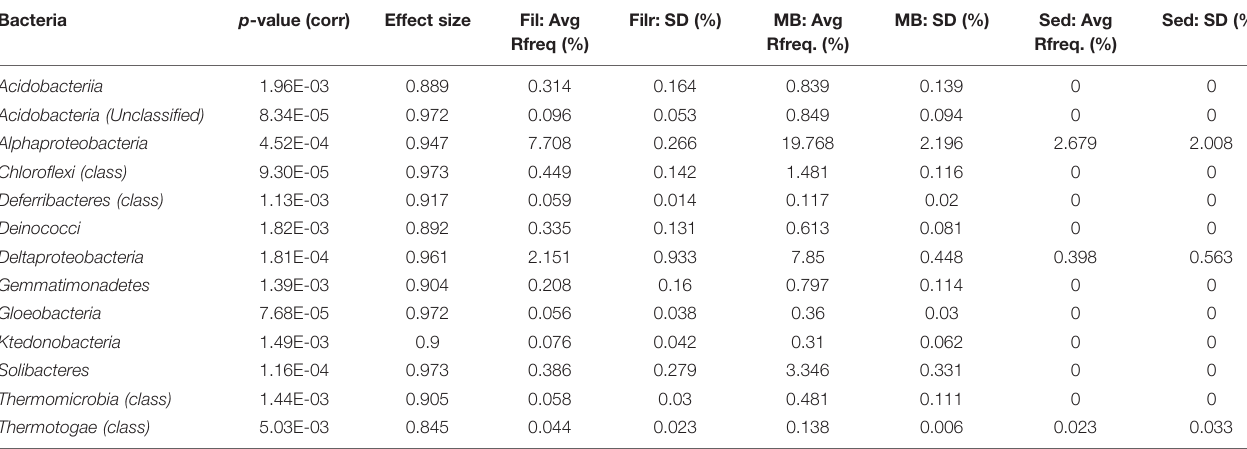
TABLE 2 | Taxonomic classes (RefSeq) that are overrepresented in microbialites relative to the surrounding environment by ANOVA using STAMP. Bacteria